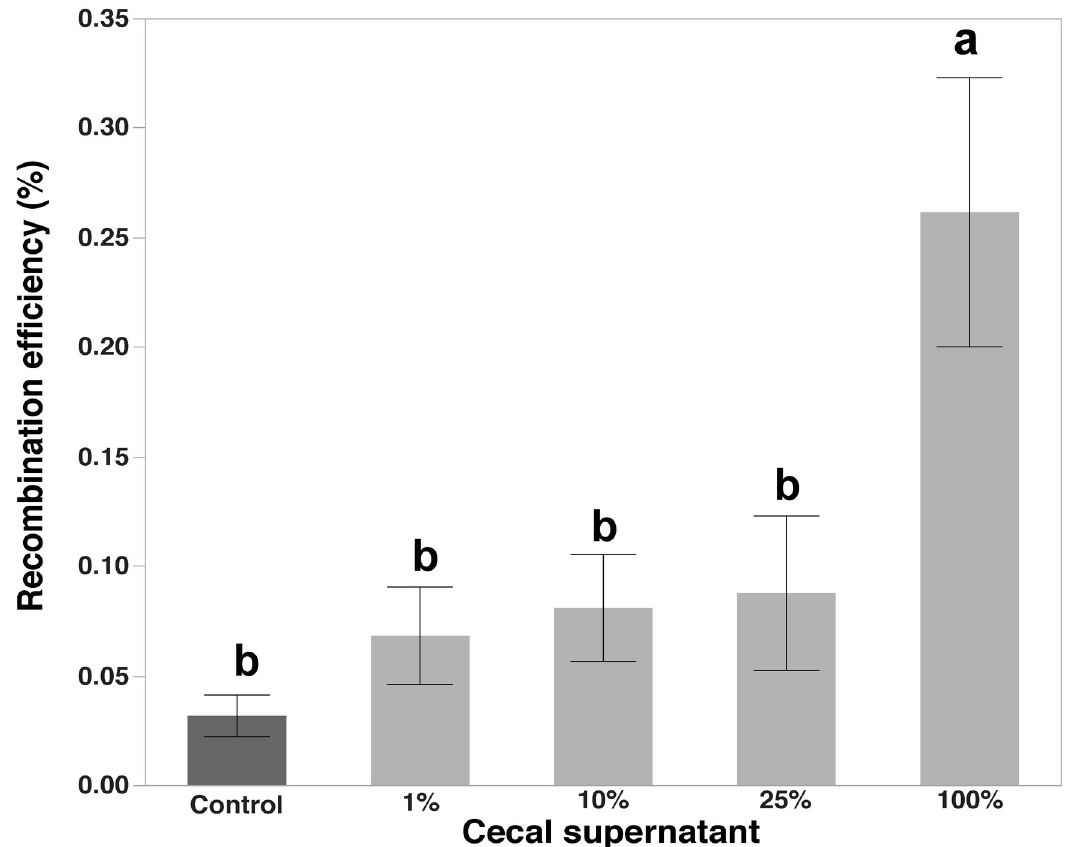
Fig 11. Changes in recombinant levels when the recombination assay performed in the presence of chicken cecal content. The recombination assay was performed in the presence of varying concentrations of chicken cecal contents: Control (0%) and Treatments (1 to 100%). Recombinant levels expressed as percentage recombinants in the total number of parent cells; the bars with different letters are significantly different at P < 0.05.